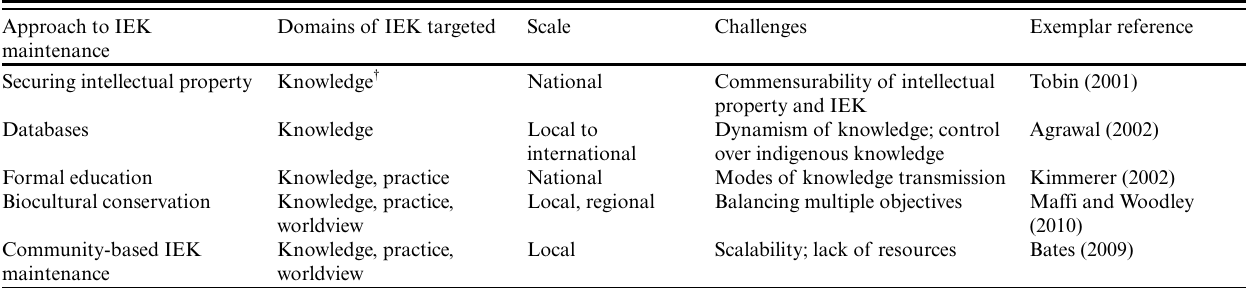
Table 1 . Summary of studies included in review of indigenous ecological knowledge (IEK) maintenance